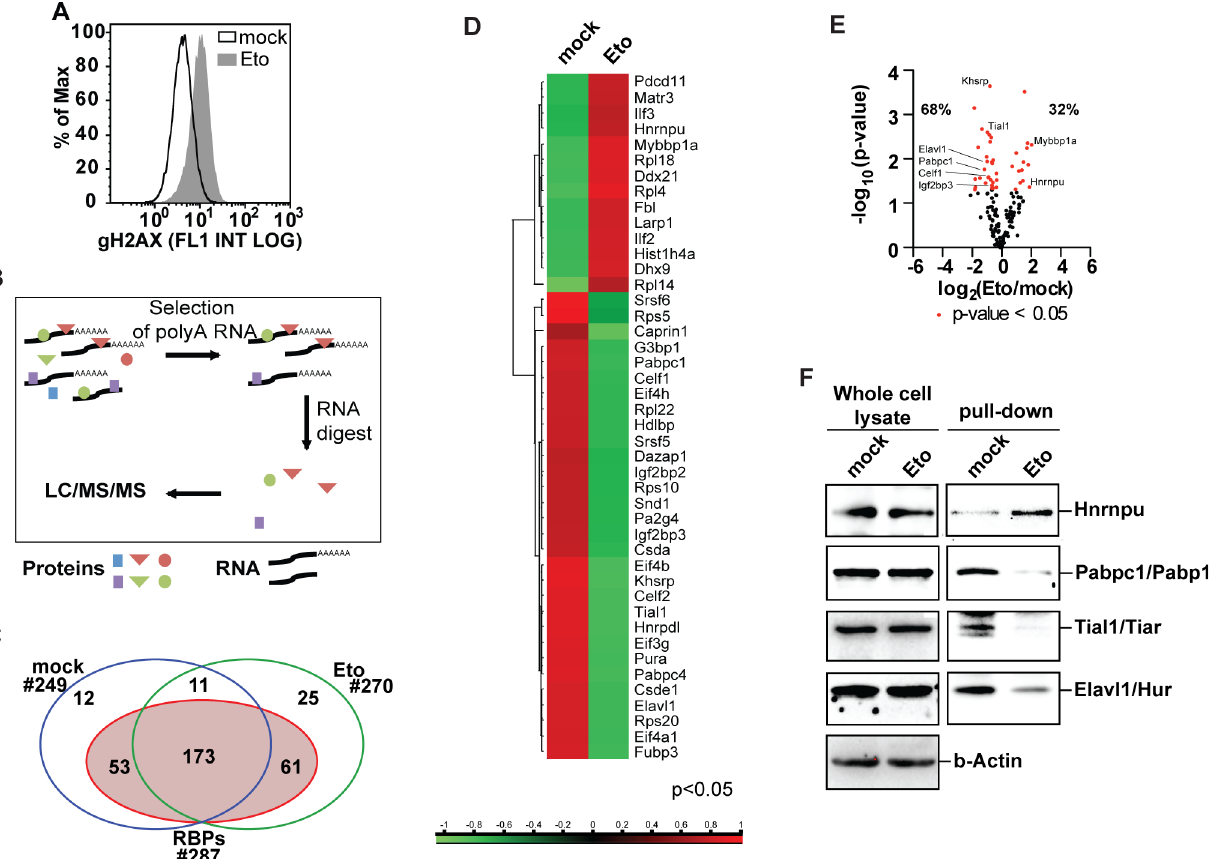
Fig 1. Changes in protein-RNA interactions in response to etoposide treatment. (A) Etoposide induces DNA double strand breaks after 6h of treatment as reported by the DSB marker γ -H2AX. (B) Schematics of the experimental procedure for the purification of RBPs show how UV-mediated crosslinking of RNA to interacting proteins was followed by poly-A selection to identify RBPs through LC/MS/MS. (C) Crosslinking followed by purification of mRNA- interacting proteins and nano LC/MS/MS identified 335 protein group hits of which 287 were known as RBPs. (D) Heat map of differentially abundant RBPs. (E) Vulcano plot representing changes in mRNA-protein interactions in response to etoposide treatment identifies Khsrp as the most significantly changed RBP in response to etoposide treatment. (F) Immunoblot analysis of proteins co-purified with poly-A-containing RNA validates protein-RNA interactome changes identified by label free LC/MS/MS (right panel). Whole cell lysates show no significant changes in protein levels of analyzed RBPs (left panel).